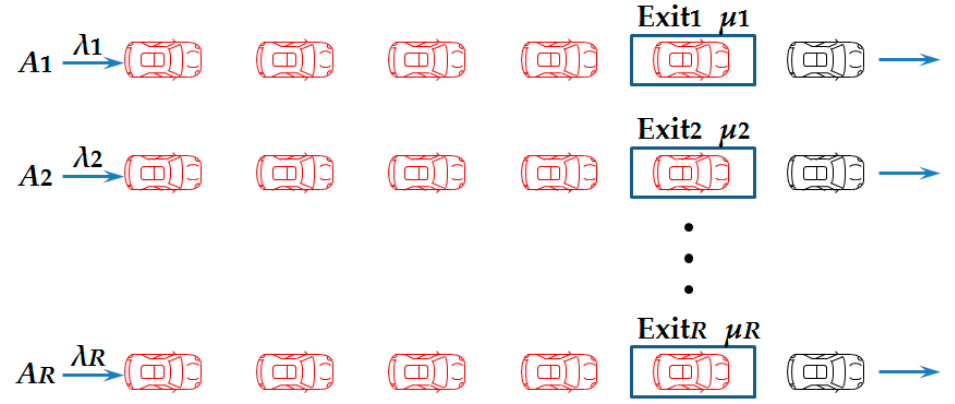
Figure 2. Queuing in a parking lot with R exits.